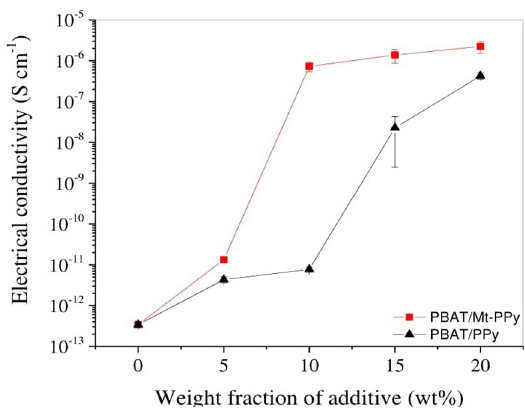
Figure 2. Effect of the conducting filler contents (Mt-PPy and PPy) on electrical conductivity.